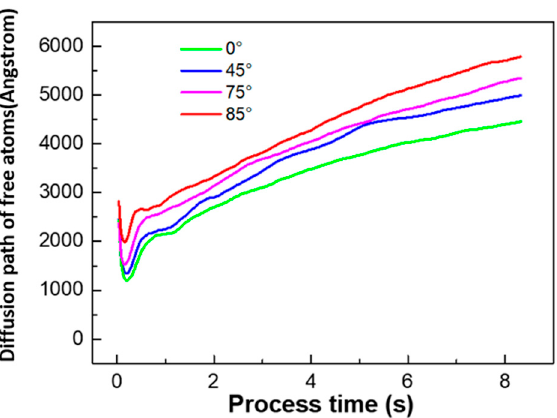
Figure 9. The curves of the free atoms’ mean diffusion path at the initial stage of film growth under different deposition angle.